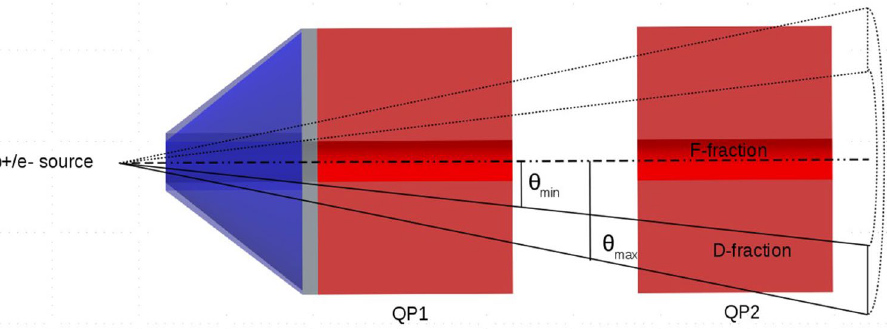
Figure 6. Proton and electron source geometrical model. Divergent fraction (D-fraction, within solid lines) and focused fraction (F-fraction, dash-dotted